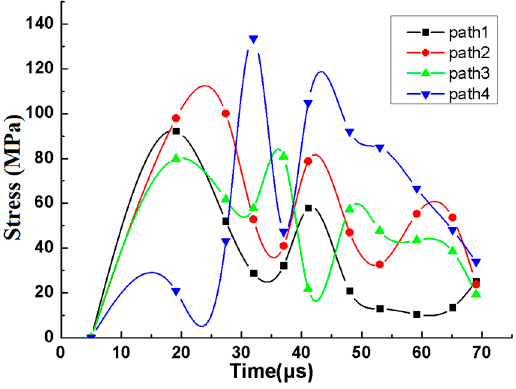
Figure 5. Relationship between stress and step time.